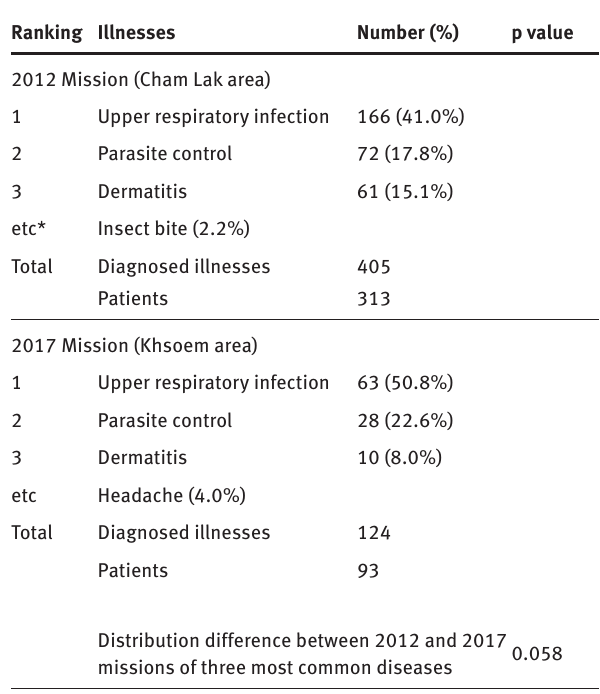
Table 2: Common cases of patients under the age of